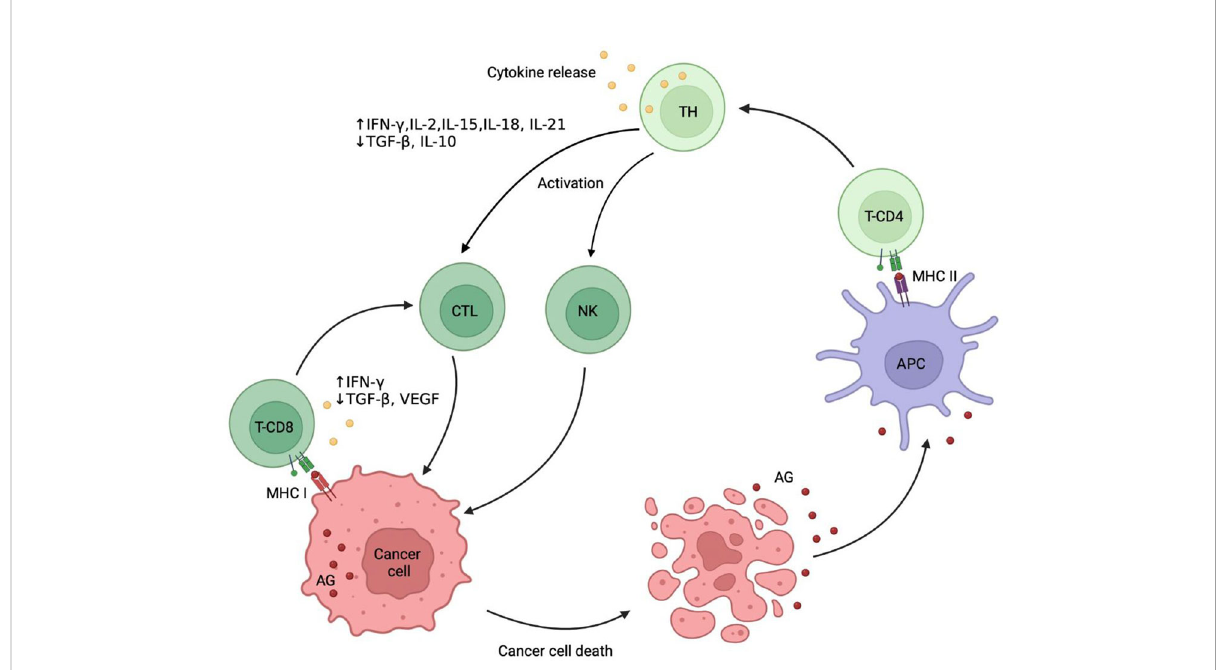
FIGURE 1 Cancer immunity cycle. Immunogenic death of tumor cells leads to release of tumor-speci fi c antigens (AG) that are captured by antigen presenting cells (APC) and after binding to major histocompatibility complex (MHC) class II are presented on their surface. The receptors CD4 dock to an MHC class II, activate the naive T helper (TH) cells followed by clonal selection of antigen-speci fi c T cells, their proliferation, migration into the tumor site and differentiation into cytotoxic T-lymphocytes (CTL). CTL express receptors CD8, which dock to MHC class